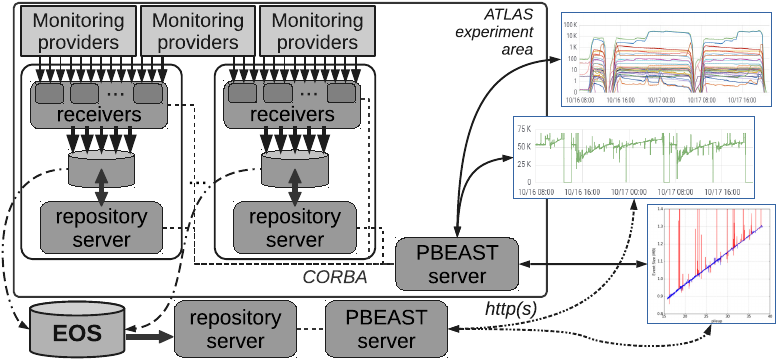
Figure 3. The PBEAST service